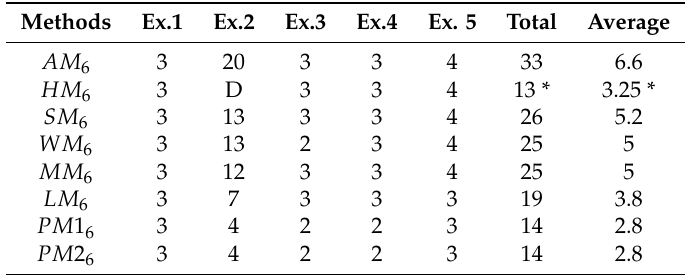
Table 7. Number of iterations taken by different methods on Examples